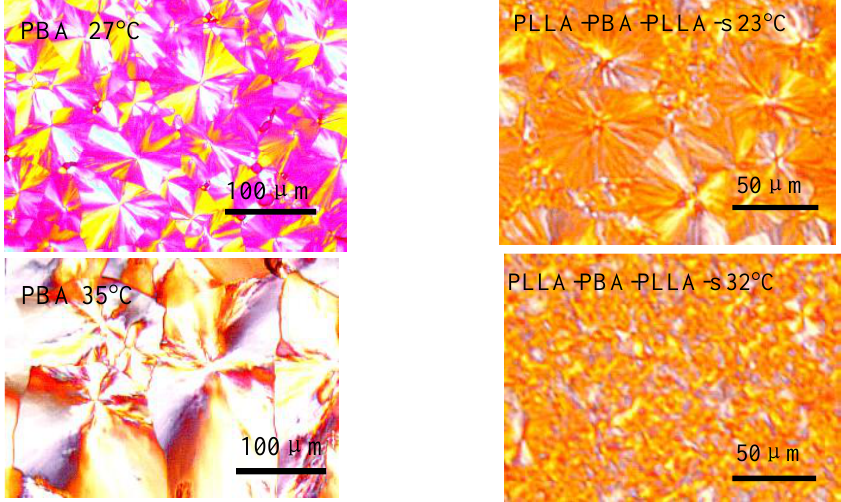
Figure 11. POM micrographs of PBA and PLLA-PBA-PLLA-s following melt crystallization at the characteristic temperatures under the thermal program 1.